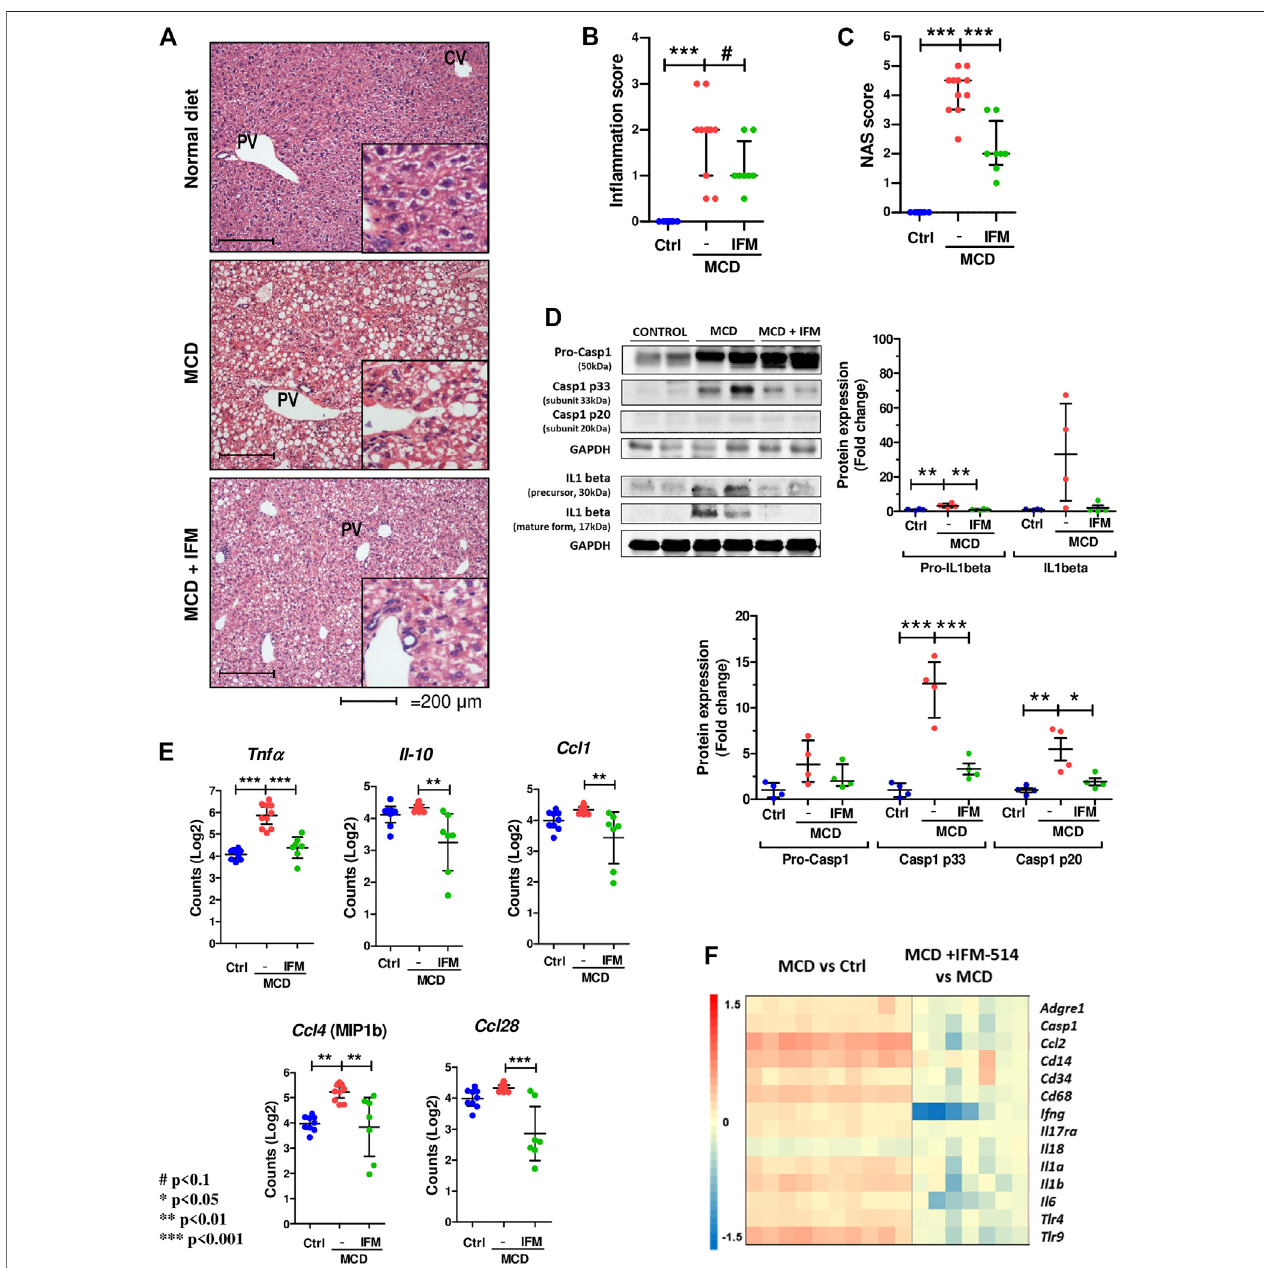
FIGURE3| IFM-514reduceshepaticin fl ammationinMCD-fed ApoE -/- mice.H&Estaining (A) in fl ammationscore (B) andNASscore (C) inIFM-514-treatedMCD-fed ApoE -/- mice.Caspase-1p33,caspase-1p20,pro-caspase-1,matureIL-1 β andpro-IL-1 β proteinexpression (D) .In fl ammasome-relatedgeneexpression (E) .Heatmapfor hepaticin fl ammationsetofgenes (F) .Scaleandgenesareprovidedonheatmap.Resultsareexpressedasthemean ± standarderrorofthemean(SEM);n (cid:1) 10/group, # p < 0.1. * p < 0.05, ** p < 0.01 and *** p < 0.001. Representative photomicrographs were captured at × 100 (scale bars (cid:1) 200 μ m) and × 200 magni fi cation (scale bars (cid:1) 100 μ m). Abbreviations: Ccl1, chemokine (C-C motif) ligand 1; Ccl4, chemokine (C-C motif) ligand 4; Ccl28, chemokine (C-C motif) ligand 28; CV, central vein; GAPDH, glyceraldehyde-3-phosphate dehydrogenase; H&E, hematoxylin and eosin; Il-10 , interleukin 10; PV, portal vein. See Supplementary Table 3 for Heatmap genes.